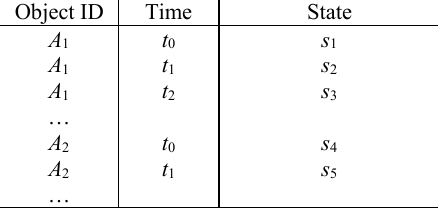
Table 1. Object-oriented data modeling